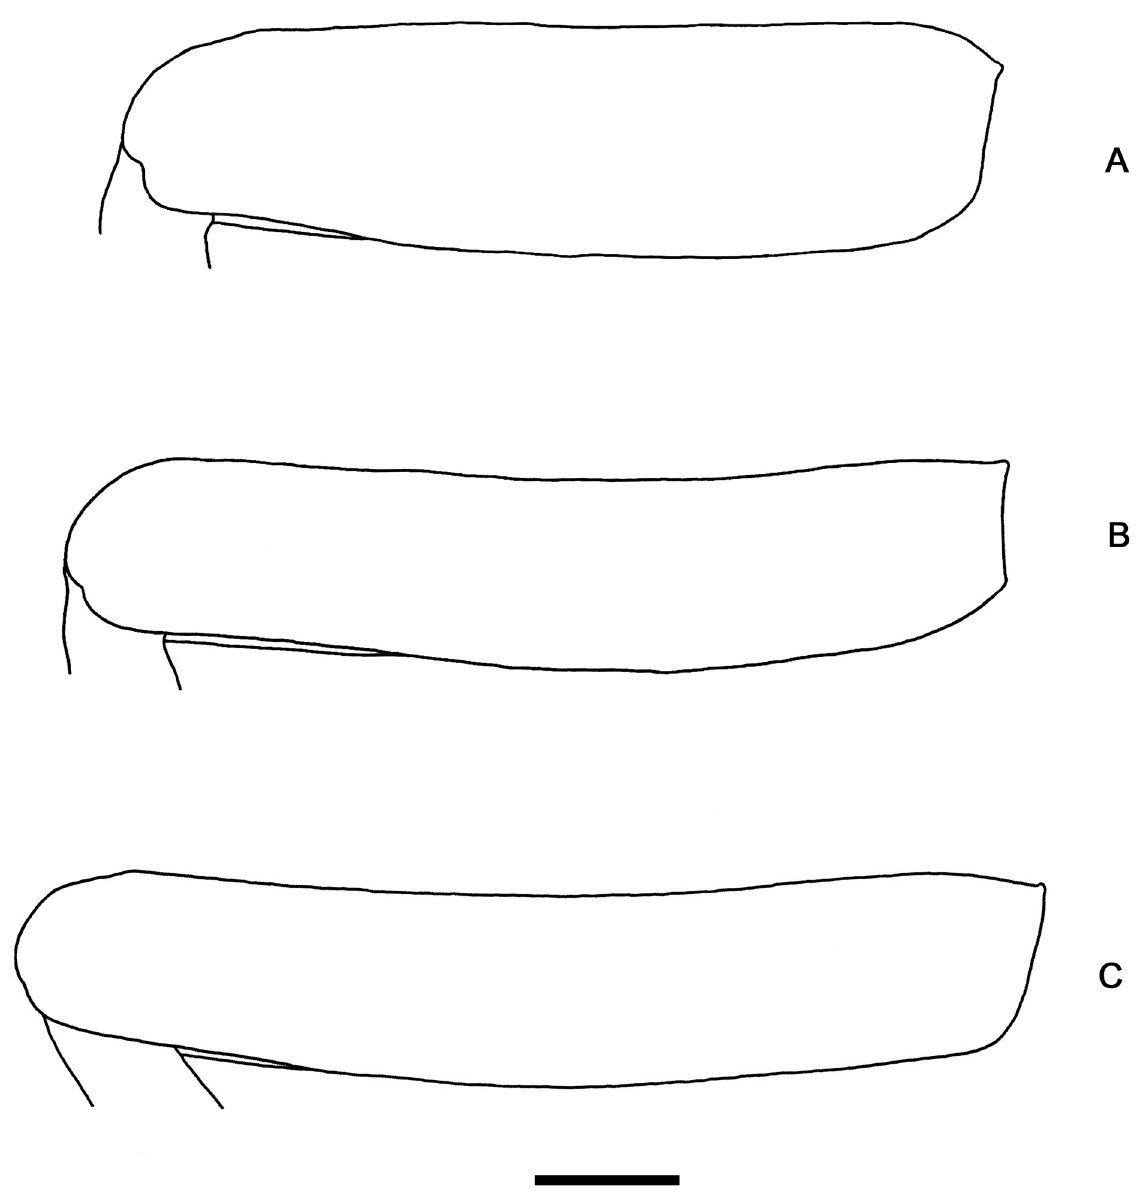
Fig. 11. Procerobaetis freitagi gen. et sp. nov., larval morphology. A . Fore femur. B . Middle femur. C . Hind femur. Scale bar: 0.1